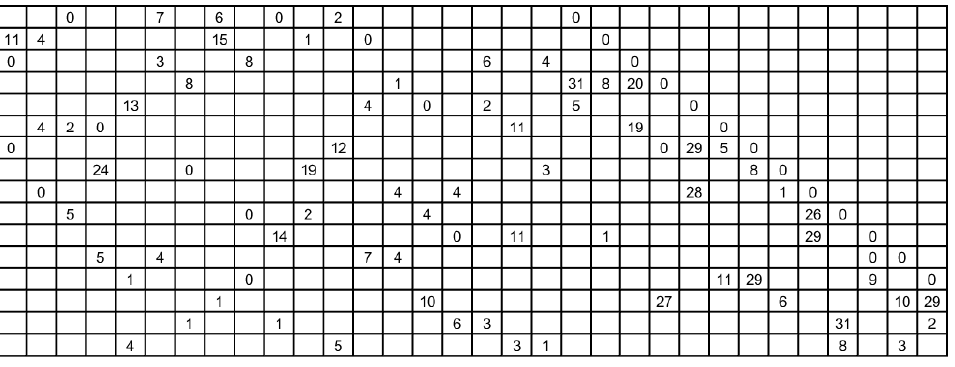
Figure 5. Parity-check matrix of a (1024,512) QC-LDPC code with submatrix size P = 32. The cyclic shift values are provided for non-zero